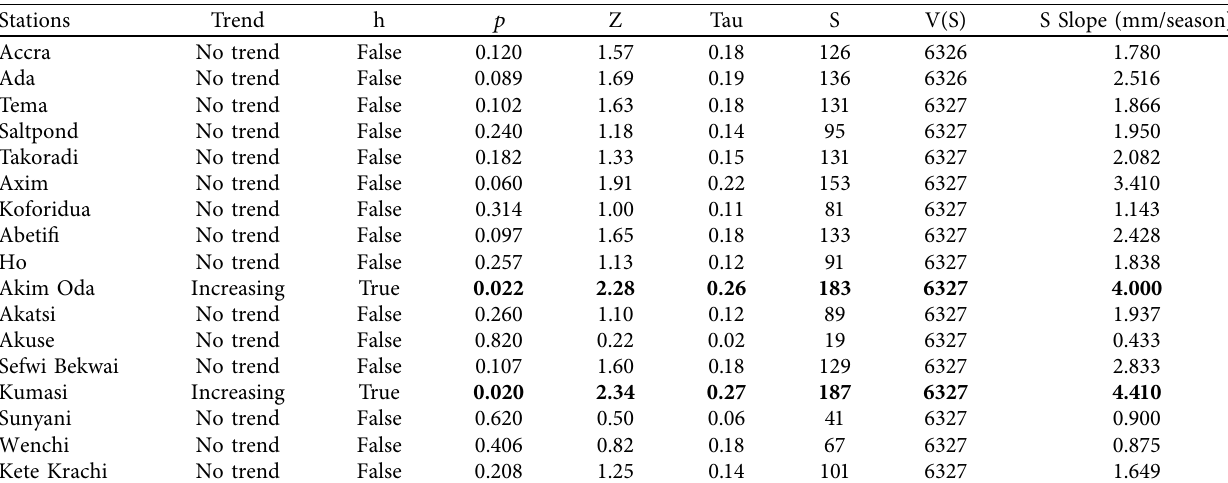
Table 4: Mann-Kendall trend analysis of minor seasonal total